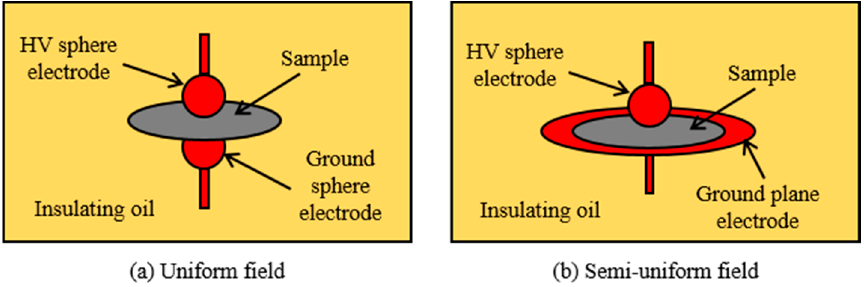
Figure 3. Electrode configurations used for measuring breakdown strength; ( a ) uniform field and ( b ) semi-uniform field. ( b ) semi-uniform field.